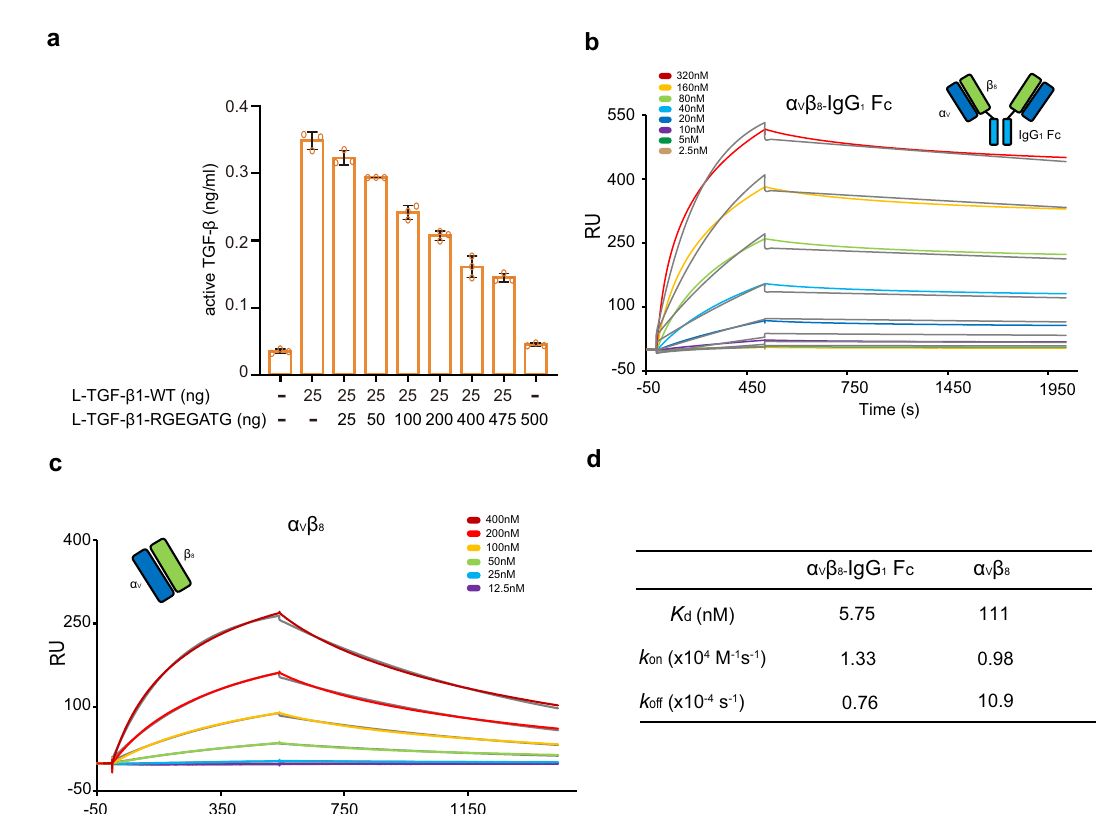
Fig. 3 | Cryo-EM structure ofthe α V β 8 /L-TGF- β 1 complex. a Sequence schematic diagramsofintegrinsubunits α V and β 8 .Theheadpieceregionsof α V and β 8 usedin ourstudyarecolored inblue andgreen,respectively.Theotherregionsof integrin are colored in gray. b Cryo-EM map of the α V β 8 /L-TGF- β 1 complex. The contour levelis0.384.Theintegrinsubunitsarecoloredasthosein a .L-TGF- β 1iscoloredin orange. The cryo-EM density of LRRC33 is too weak to visualize. c Cartoon pre- sentation of the α V β 8 /L-TGF- β 1 structure built in the fi nal model. Metal ions in the MIDAS (metal ion-dependent adhesion site) and SyMBS (syngeneic metal ion bindingsite)arecoloredinredandpurple,respectively.Calciumionsarecoloredin green. d Ribbon diagram of the interface between α V β 8 and L-TGF- β 1 . The side chainsoftheresiduesintheintegrin-bindingregionofL-TGF- β 1areshownassticks, and their cryo-EM densities (contour level of 0.384) are shown as black mesh. The proximal loop and integrin-binding (IB) loop are indicated. e Superposition of our β β 1 structurewith the reported one (PDBcode: 6UJA)based on integrin α V 8 /L-TGF-